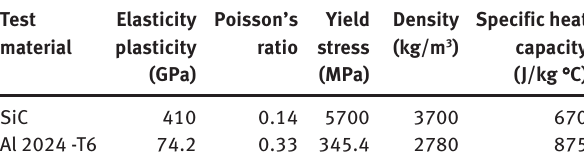
Figure 2: The destruction of the particles under the